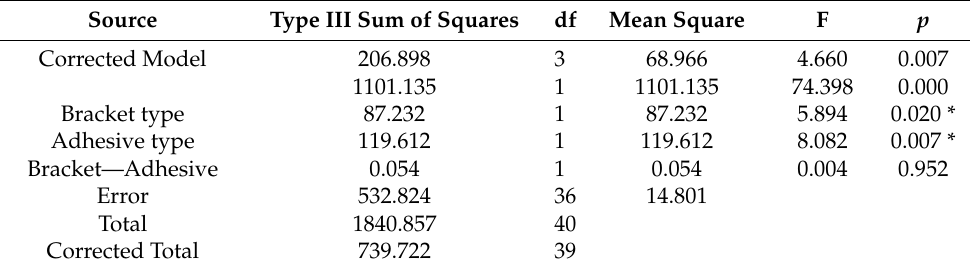
Table 3. Two-way ANOVA for the interaction effect of bracket and adhesive on change in tooth color ( ∆ E).